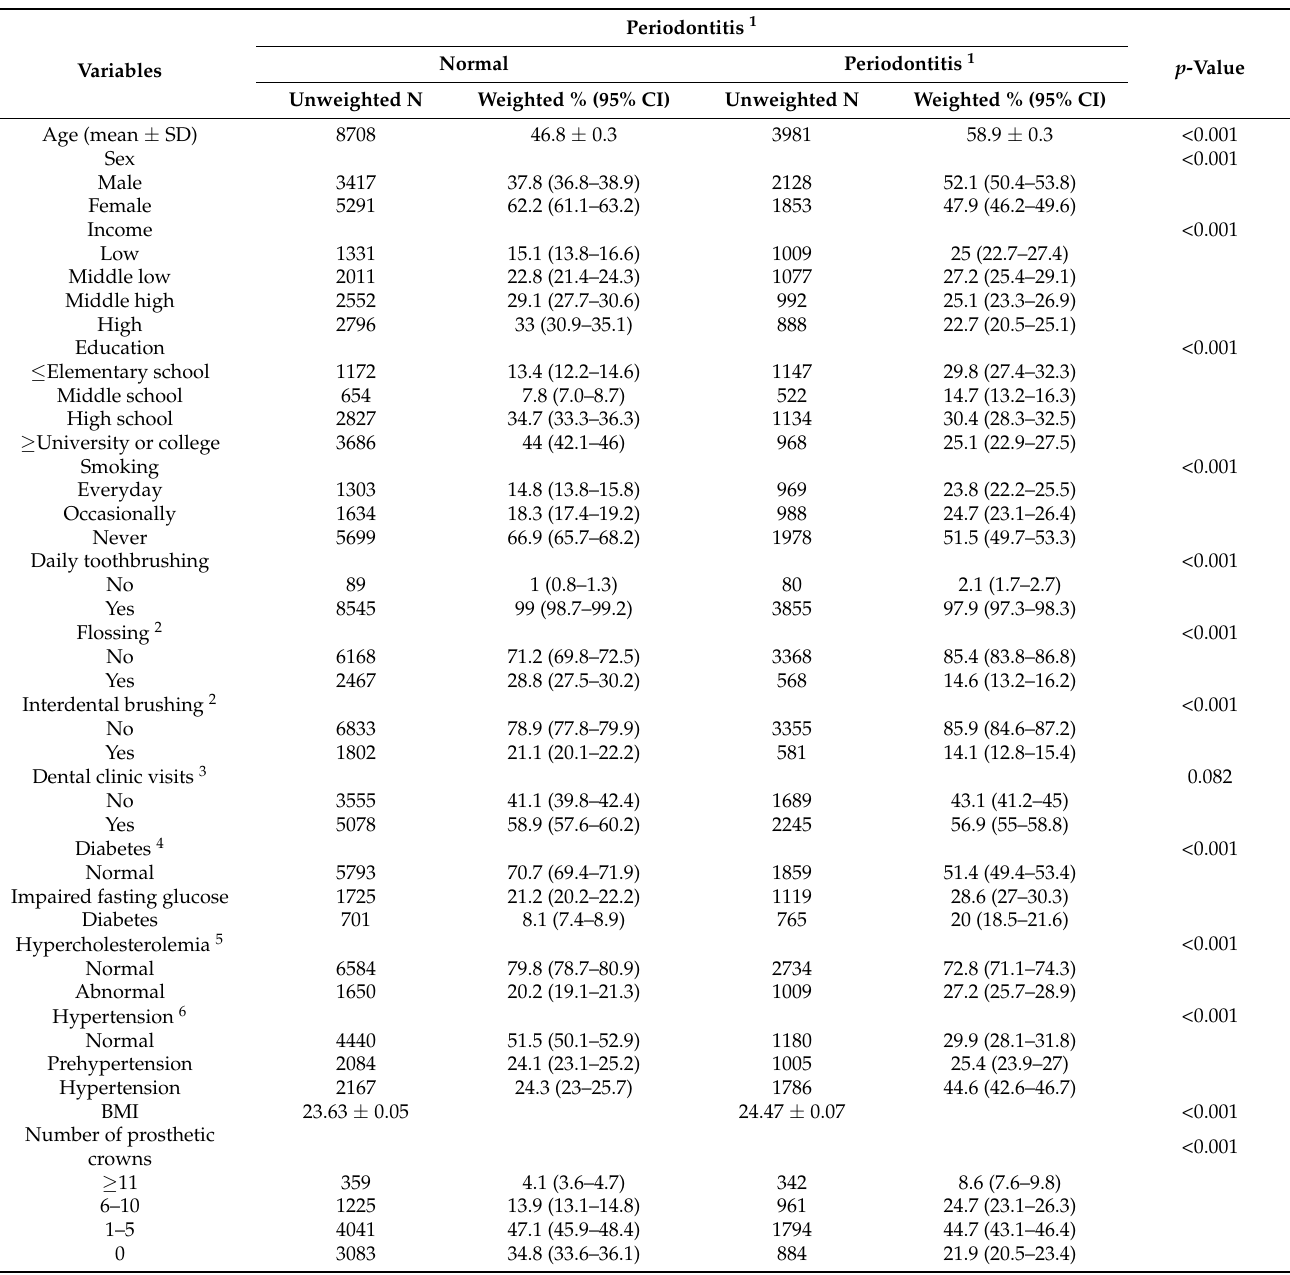
Table 1. Characteristics of the study population stratified by